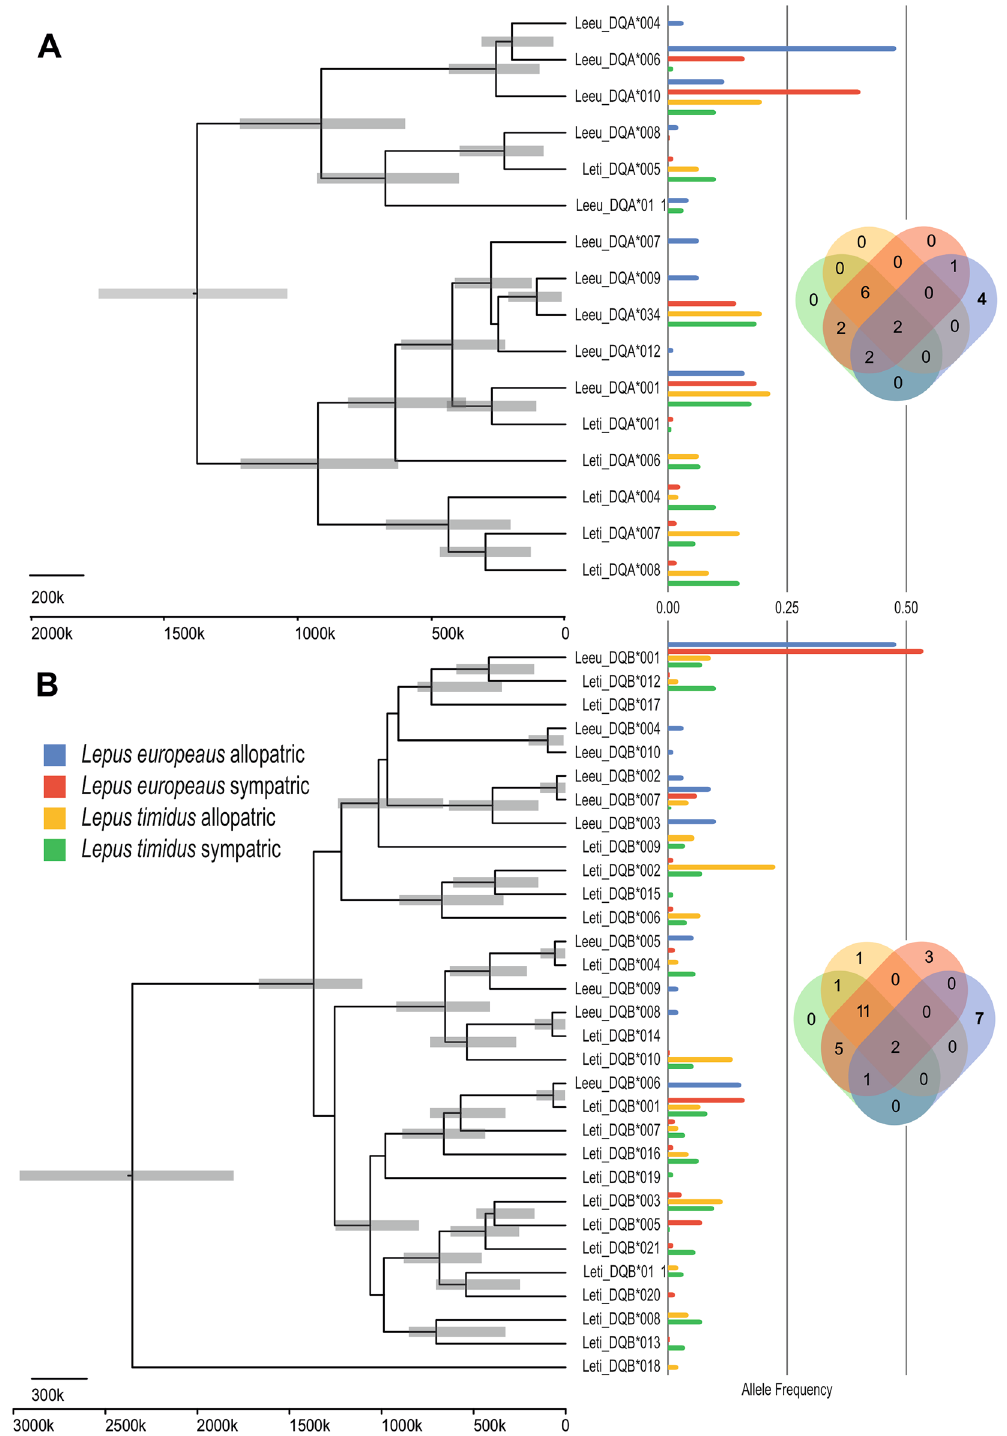
Figure 3. Ultrametric trees for the MHC allele relations and allele frequencies in Finnish mountain hares ( Lepus timidus ) and brown hares ( Lepus europaeus ) for assumed allopatric and sympatric populations. ( A ) DQA locus, ( B ) DQB locus. Tip labels of the tree represent the individual alleles in this study as identified by the following nomenclature, hare species_Locus*allele, for example, Leeu_DQA*001 is brown hare DQA locus 001. The scale of the ultrametric trees is in years from the present, based on a strict clock assumption of μ DQA = 10% and μ DQB = 11%. The bars over the tree nodes represent the 95% confidence interval of the node height. The colors of the allele frequency bar chart represent each of the populations tested. Due to the scale of the allele frequency not all bars are observable, for all allele frequencies refer to Table S3. Venn diagrams depict the numbers of unique and shared alleles for each population (same coloring as for the allele frequency bar chart). Private allele numbers in